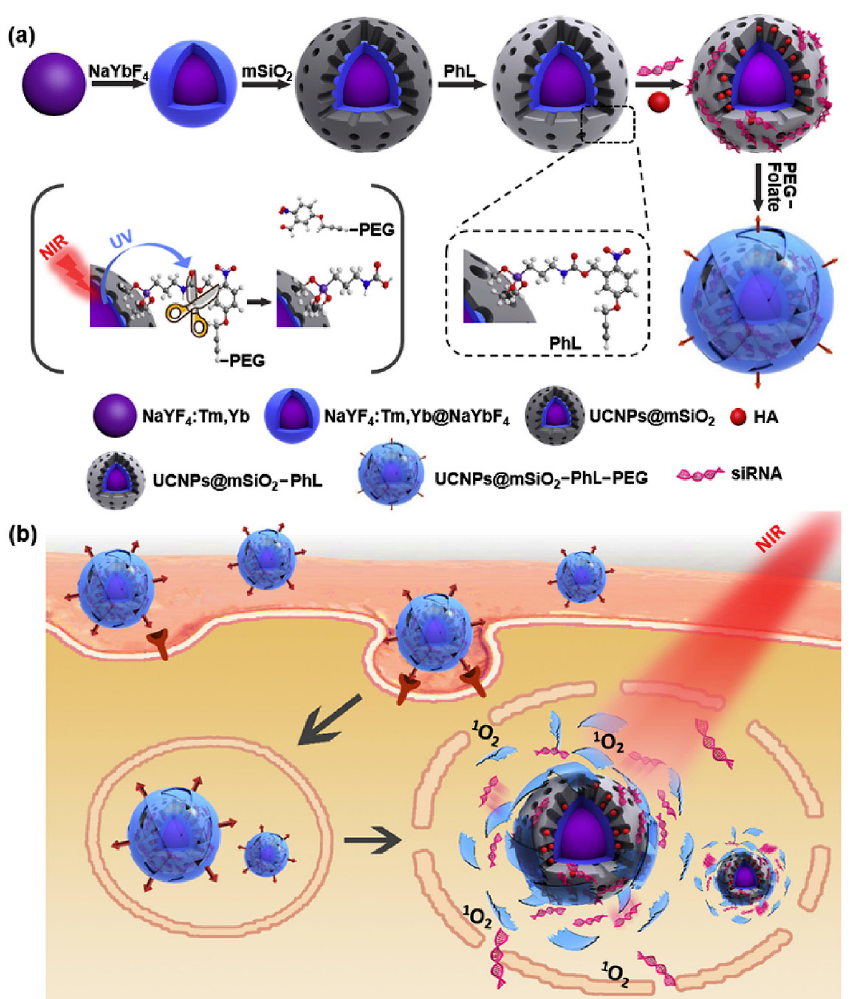
Figure 13. Graphical representation of ( a ) synthesis of nanoparticles, and ( b ) receptor-mediated endocytosis and NIR controlled intracellular delivery of siRNA. Reproduced with permission from reference [64].